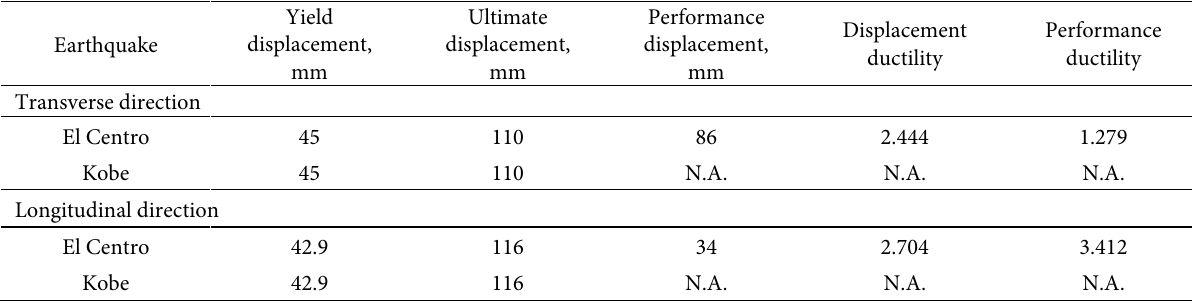
Performance ductility